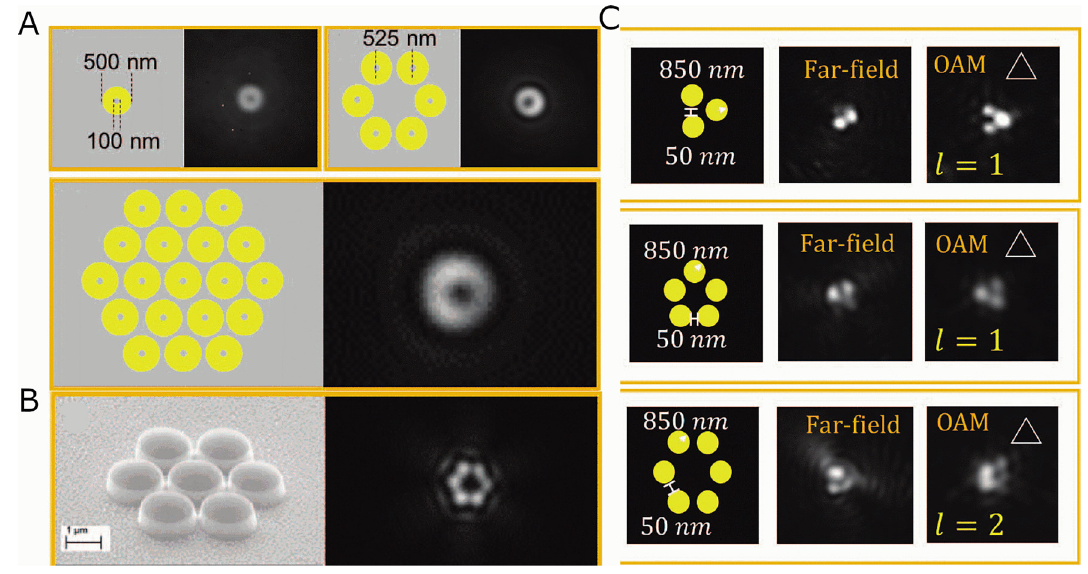
Figure 12: Vortex beams and orbital angular momentum. (A) Schematics and experimental far-field mode structure for coaxial metal nanolasers of different array sizes. Vortex beam with no angular momentumisobservedregardlessofarraysize.(B)SEMimage(left)andfar-fieldmodestructureofsevennanodiskarray(right).Avortexbeam with angular momentum is confirmed. (C) Varying nanodisk array sizes (left), their corresponding far-field patterns (middle), and their respective topological charges (right). (A), (B), and (C) adapted and reprinted from a study by Hayenga et al. [81] with